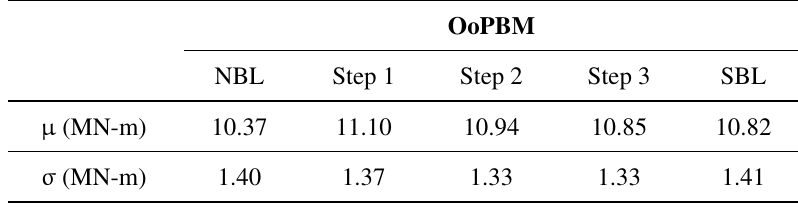
Table 4. Ten-minute maximum load statistics from 2200 wind fields (SBL versus baseline NBL and modified